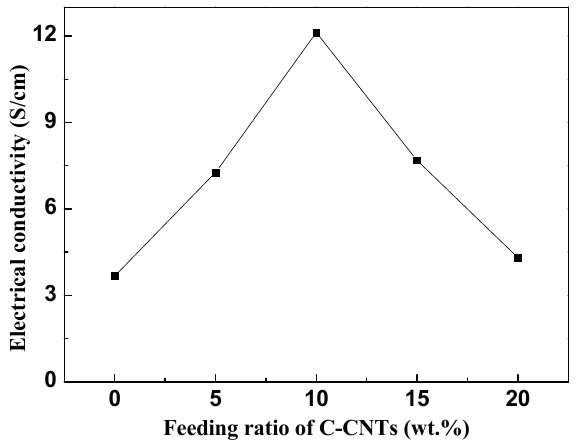
Figure 5. Electrical conductivity of the pure PANI and C-CNTs/PANI composites.